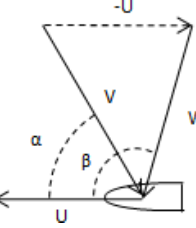
Figure 4. Definitions of the true wind angle β and apparent wind angle α